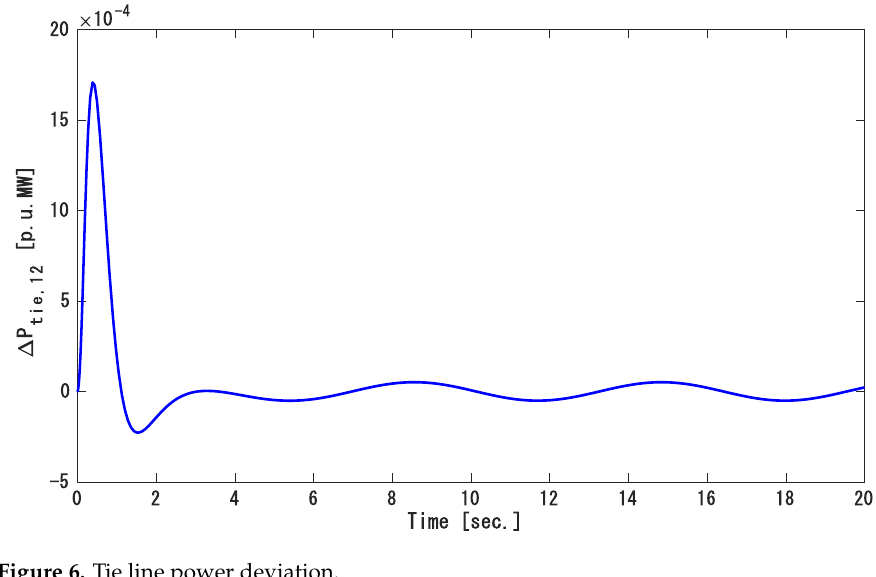
Figure 6. Tie line power deviation.